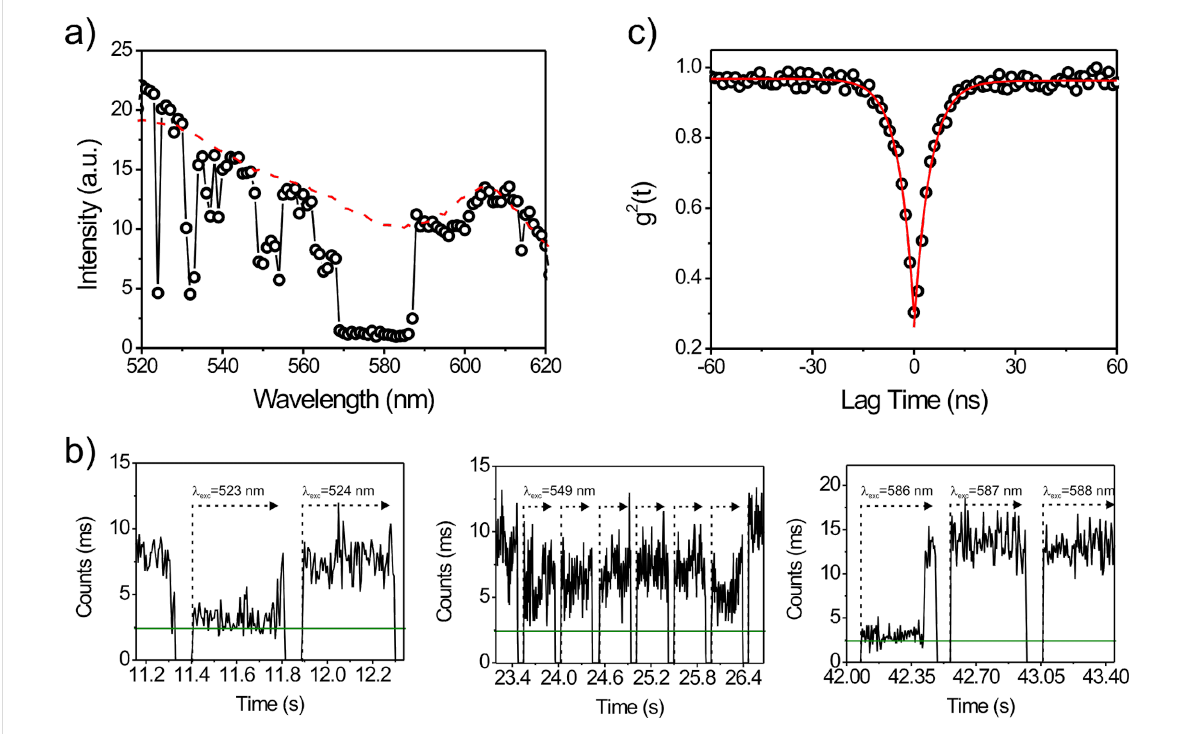
Figure 1: Single emitter characteristics observed by excitation spectroscopy of isolated quantum dots. a) Excitation spectrum of a single quantum dot (open circles) with typical intensity intermittencies that result in drops and gaps in the spectrum. The ensemble excitation spectrum is shown for com- parison (red dashed line). b) Intensity trajectories of a single quantum dot for selected excitation wavelengths (green line marks the background level). c) Photon antibunching curve of a single quantum